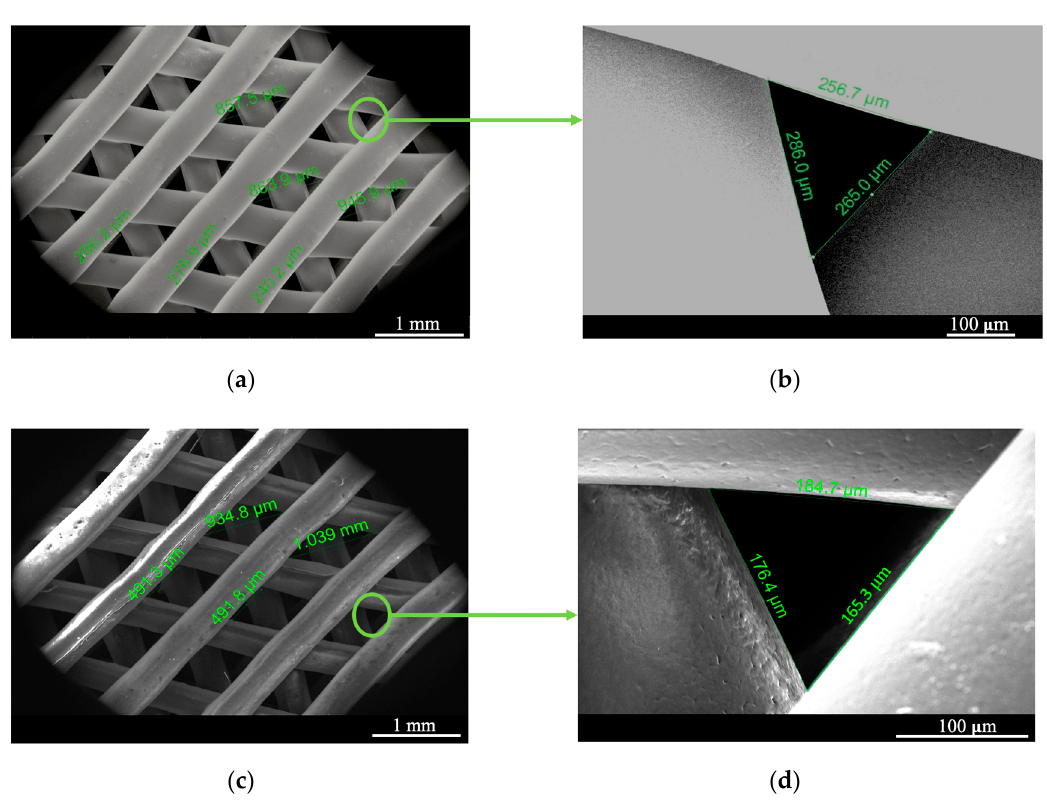
Figure 5. ( a ) Top view of PCL scaffold; ( b ) details and size of a pore; ( c ) top view of the scaffold with the conductive TrGO particles; ( d ) detailed image of a scaffold pore is shown.